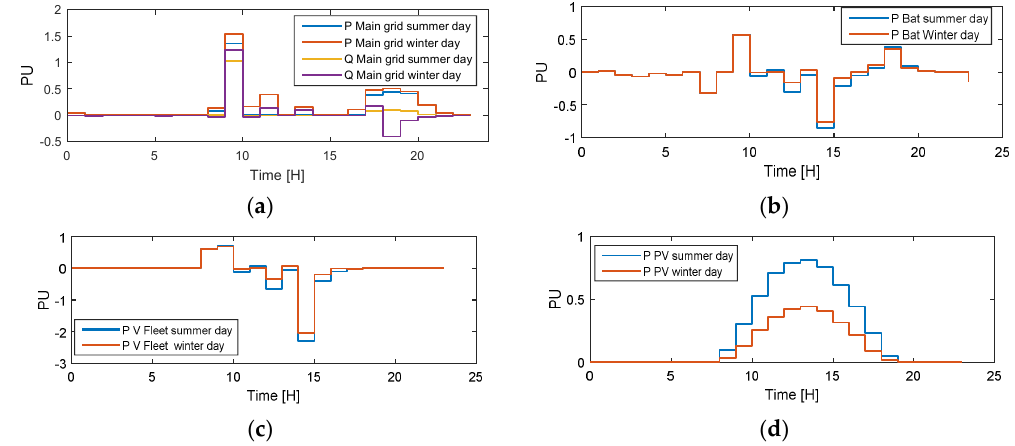
Figure 12. Comparison between power generation on summer and winter days. ( a ) Active and reactive powers exchanged with the main grid.; ( b ) Active power provided by the battery; ( c ) Active power provided by the vehicle fleet; ( d ) Active power provided by the photovoltaic panel.